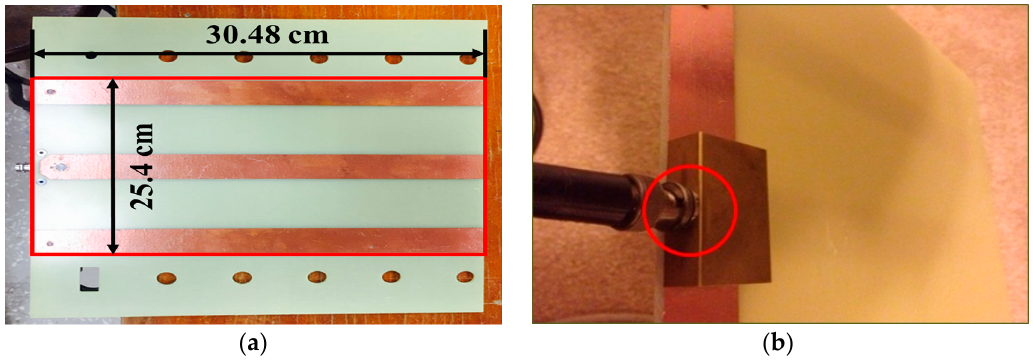
Figure 7. Developed TDR Probe. ( a ) Flat probe; ( b ) connection.